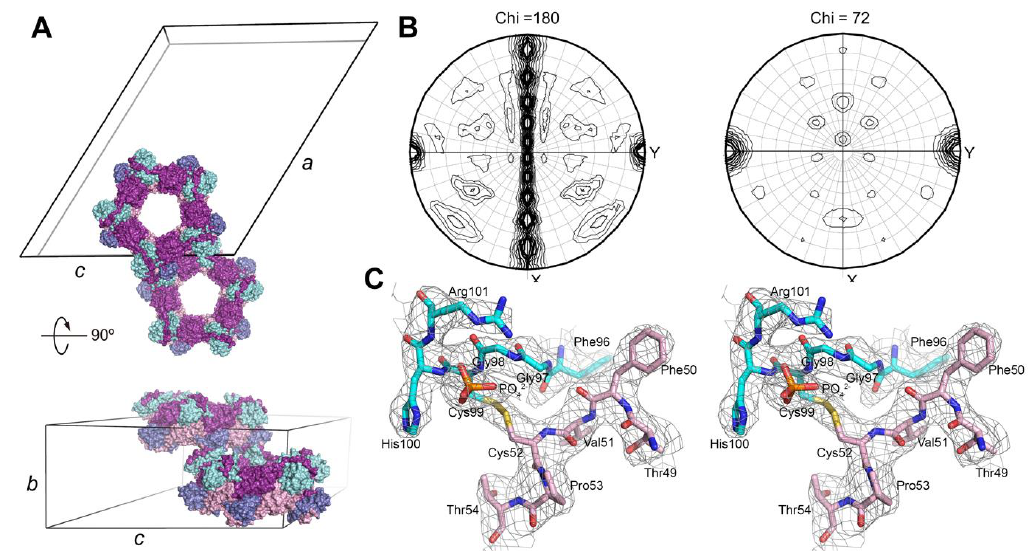
Figure 2. Crystal structure of the Srx complex with the Prx1 decamer. ( A ) Packing of the complex within the C 2 unit cell. Two toroid-shaped complexes containing ten Prx dimers (violet/purple) and twenty Srx molecules (cyan/blue) were found in the asymmetric unit. Cell dimensions: a = 330.8 Å , b = 110.0 Å , c = 260.2 Å , α = 90°, β = 122.3°, γ = 90°. ( B ) Self-rotation function calculated using the program MOLREP with data in the 10–4 Å resolution range and an integration radius of 30 Å. The χ = 180° plot contains ten two-folds separated by 18°. These axes are perpendicular to a five-fold axis indicated on the χ = 72° plot, consistent with the Srx-Prx complex having 52-point group symmetry. ( C ) Stereoview of representative 2 F o – F c electron density map centered on the engineered Srx-Prx disulfide contoured at 1 σ.